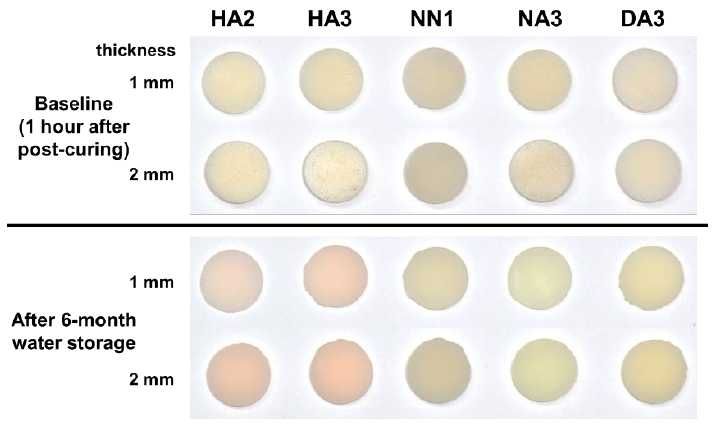
Figure 1. Photographs of the qualitative color changes of five 3D printable dental material specimens.